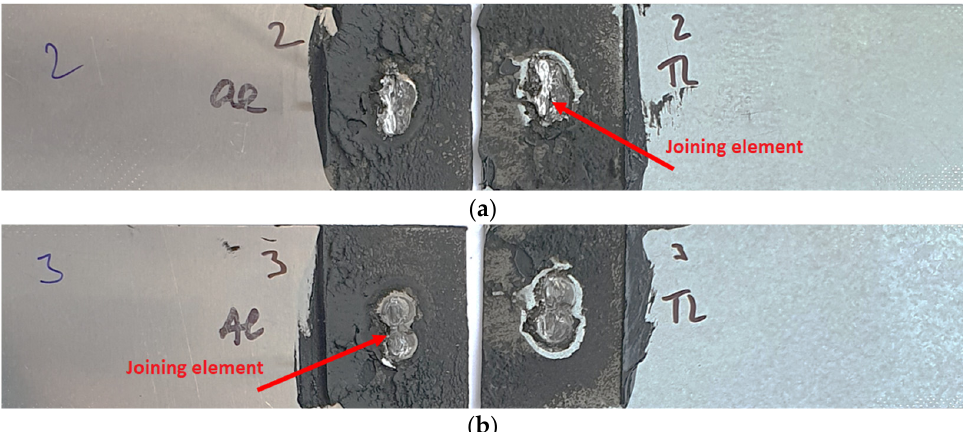
Figure 12. Fracture surfaces of Al-TL test joints made by resistance spot welding and AB after tensile shear test: ( a ) sample 2 and ( b ) sample 3, rubber based adhesive.